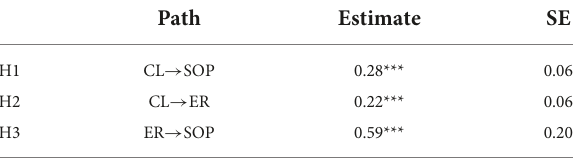
TABLE 6 Standardized direct path coefficients of the hypothesized model. Path Estimate SE